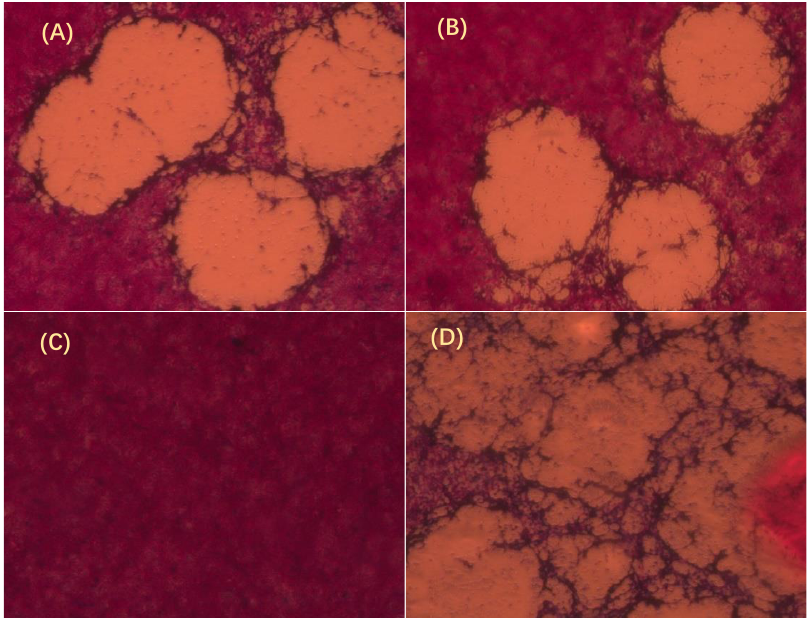
Fig. 5. Gm IFN-γ inhibits Spring viremia of carp virus (SVCV) growth observed by plaque assay. (A) Gm IFN-γ from yeast expression. (B) Gm IFN-γ from prokaryotic expression. (C) EPC was used as a negative control. (D) EPC was infected by SVCV as a positive control. Live cells were stained red with neutral red indicator. The concentrations of purified Gm IFN-γ from yeast expression and prokaryotic expression were both 100 μg/mL.